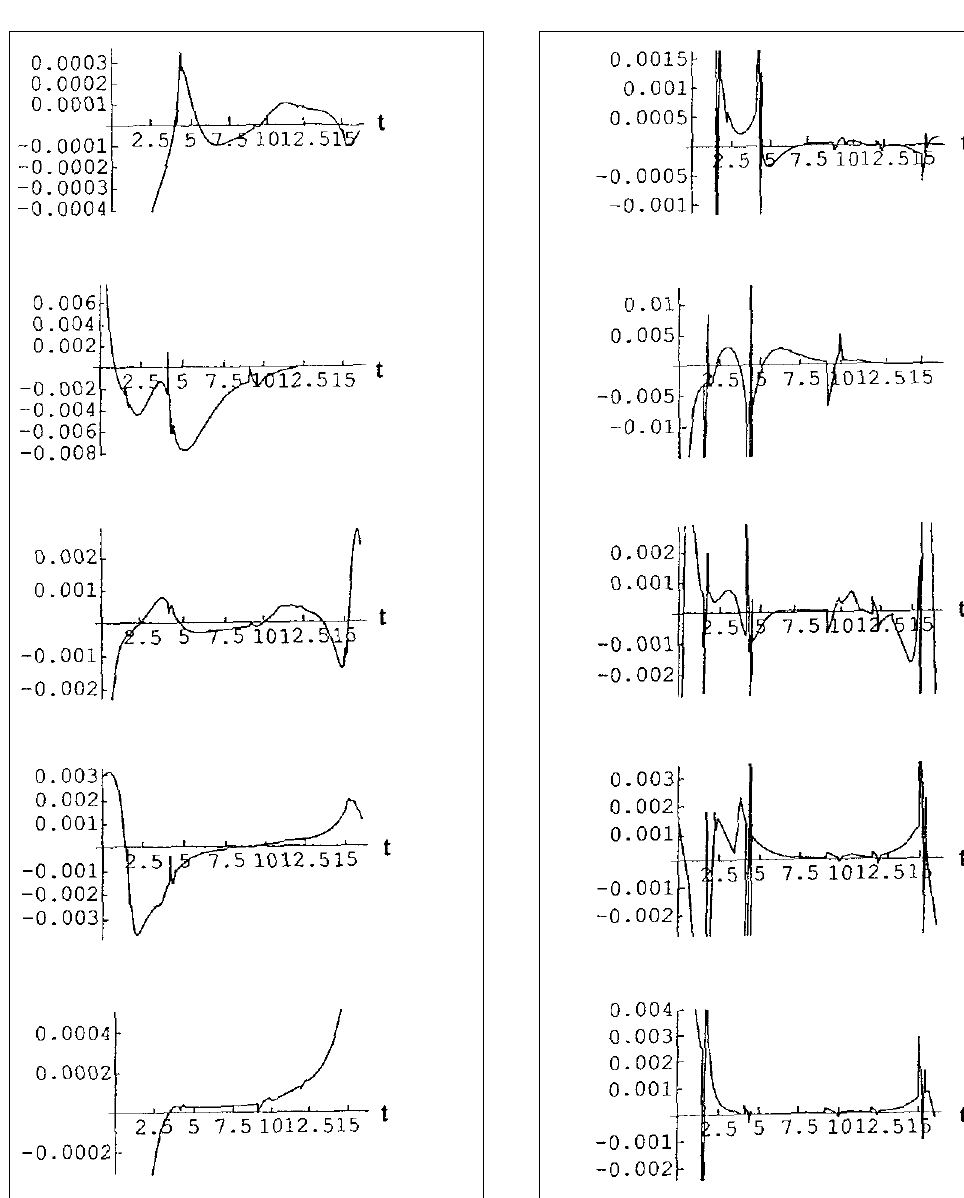
. (x,t) : the plots of (cid:95) (x = 1,2,3,4 .10 (cid:60) 3 [m] and { t } in the scale i